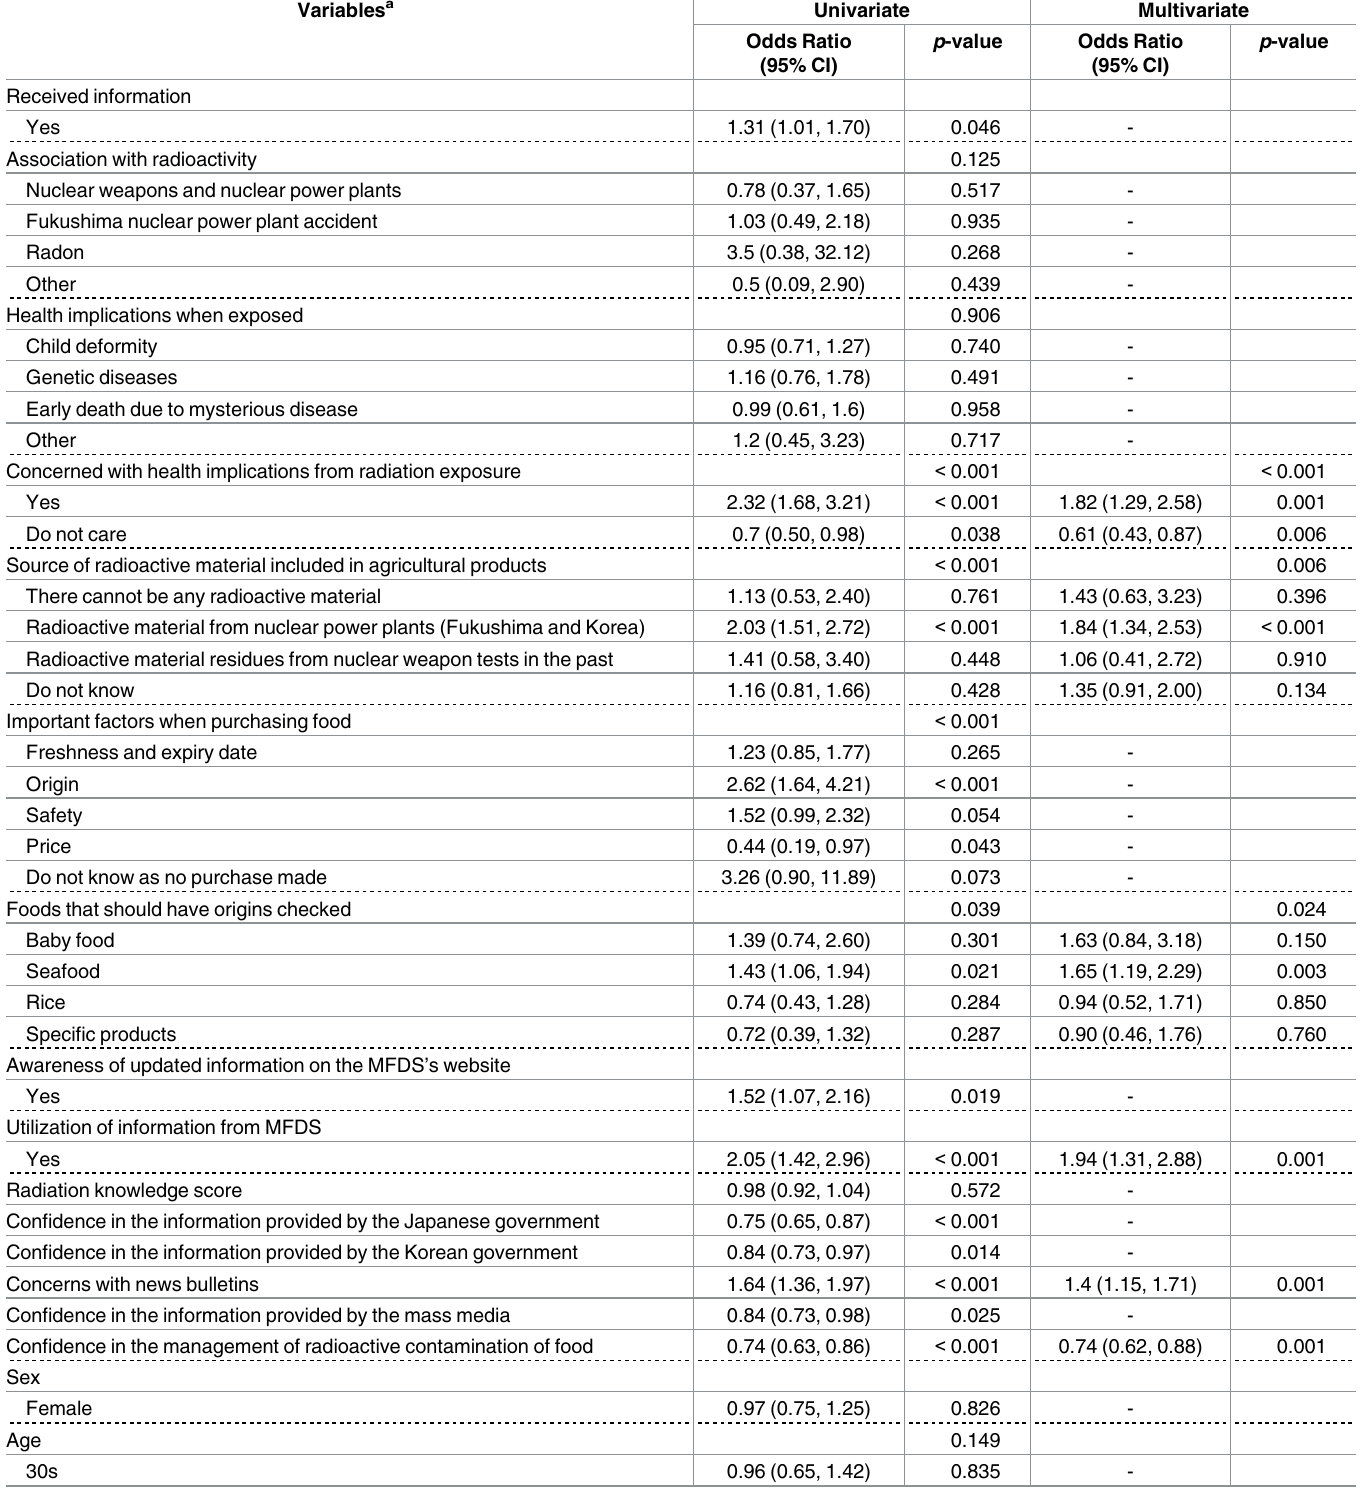
Table 5. Factors associated with the decreasein seafood purchase frequencies after the Fukushima nuclear power plant